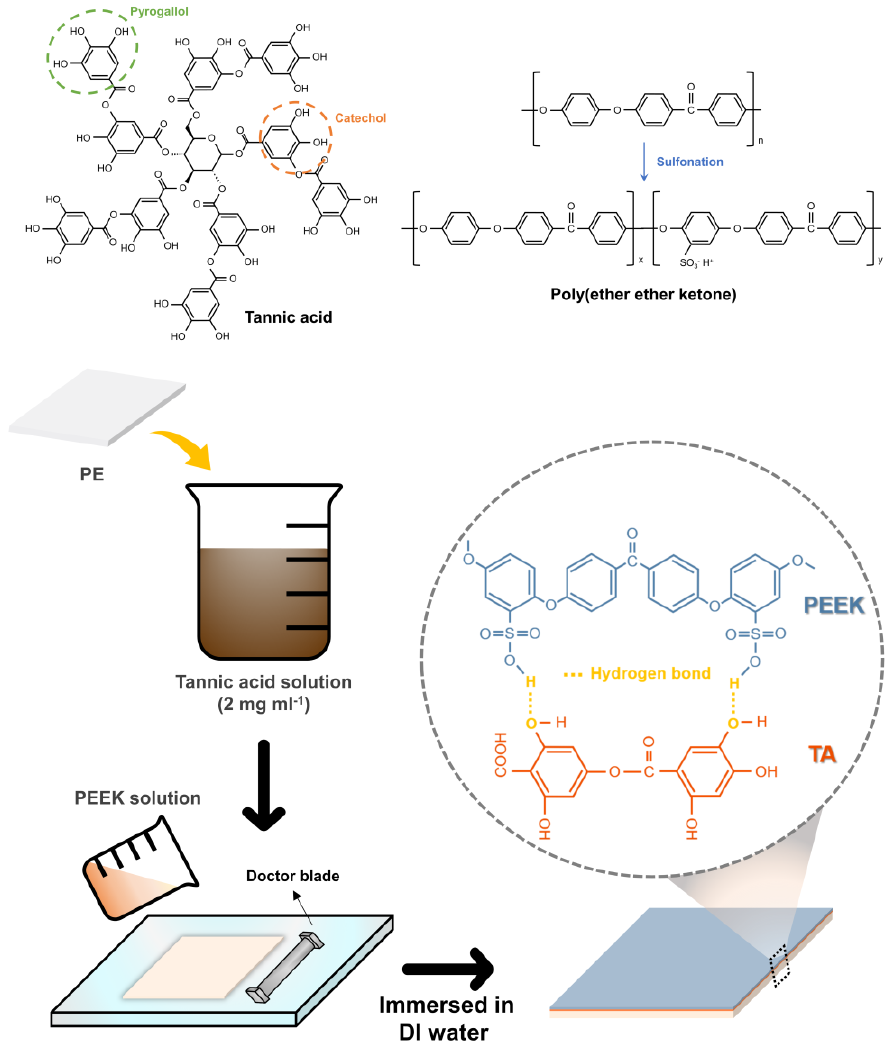
Figure 1. Chemical structures of TA and sulfonated PEEK; schematic of surface modification of the PE separator and possible reaction mechanism of TA and PEEK.